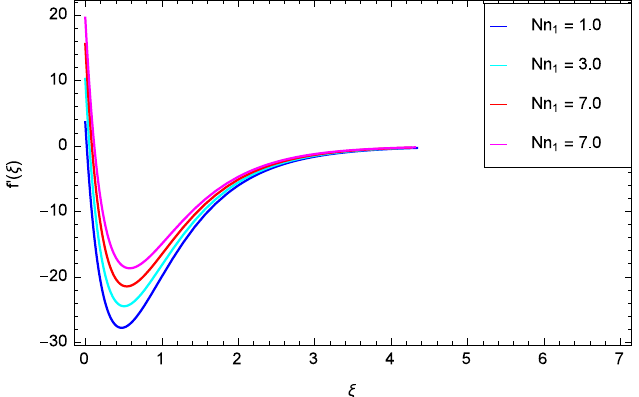
Figure 5. Impact of the non-Newtonian parameter Nn 1 on velocity f (cid:48) ( ζ )